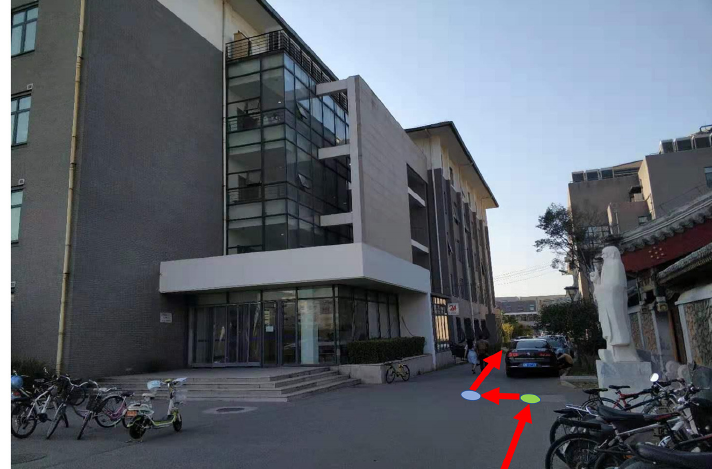
Figure 14. A narrow path with tall teaching buildings on both